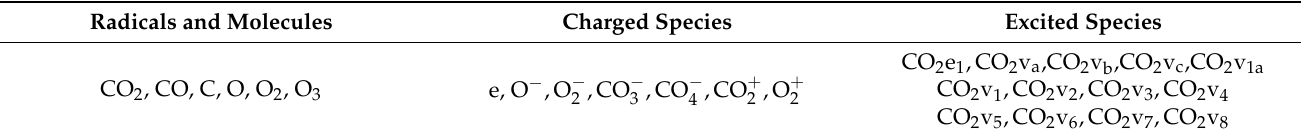
Table 1. Species taken into account in the chemical